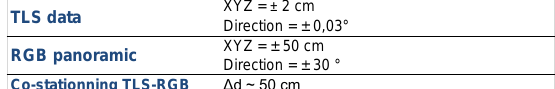
Table 2: Approximate sizes of the files generated through the TLS + RGB acquisition TLS data Size of 1 station raw dataset